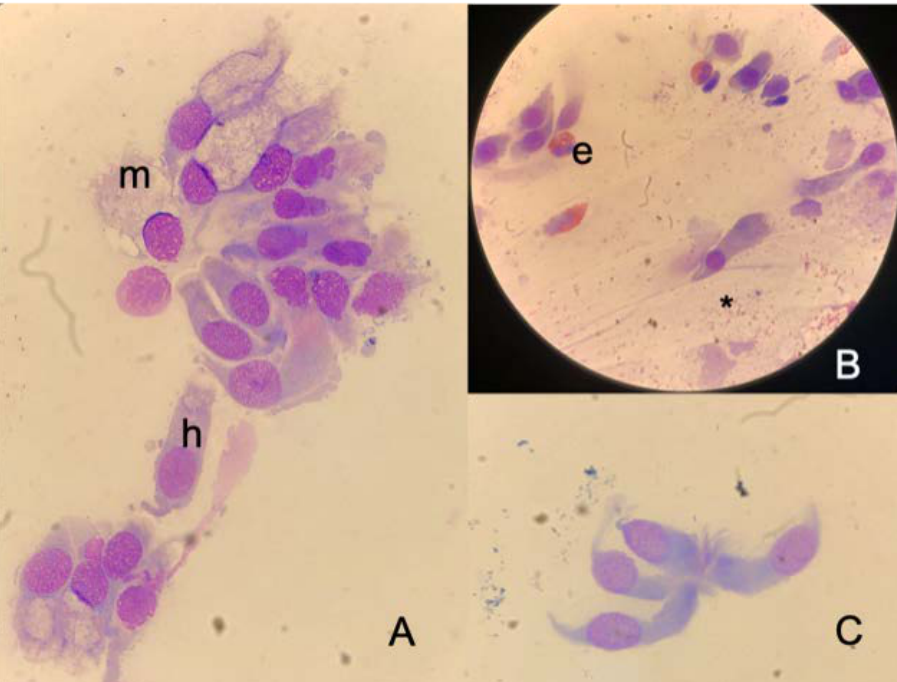
Figure 3. Nasal cytology: normal finding ( A )with muciparous cells (m) and hair cells (h), inflamma- tory infiltration ( B ) by eosinophils (e) partially degranulated (*) and a group of hair cells ( C )—May Grunwald Giemsa staining, original magnification ×1000.